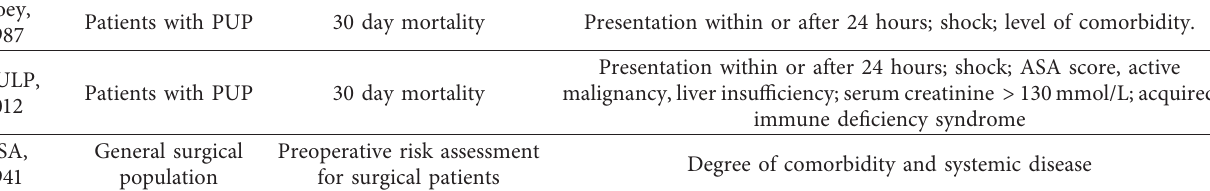
Table 3: Overview of predictive